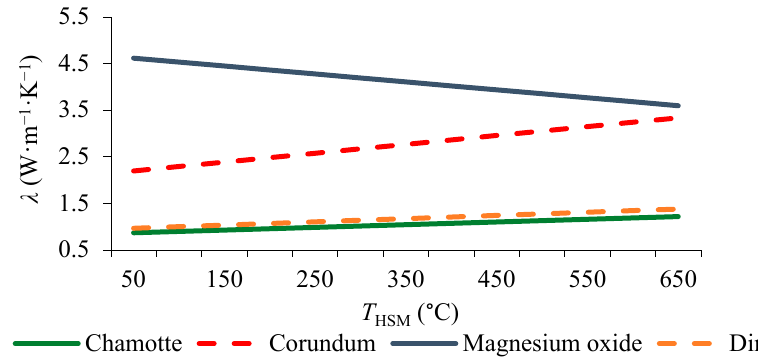
Figure 3. Dependence of thermal-conductivity coefficient on temperature T HSM .